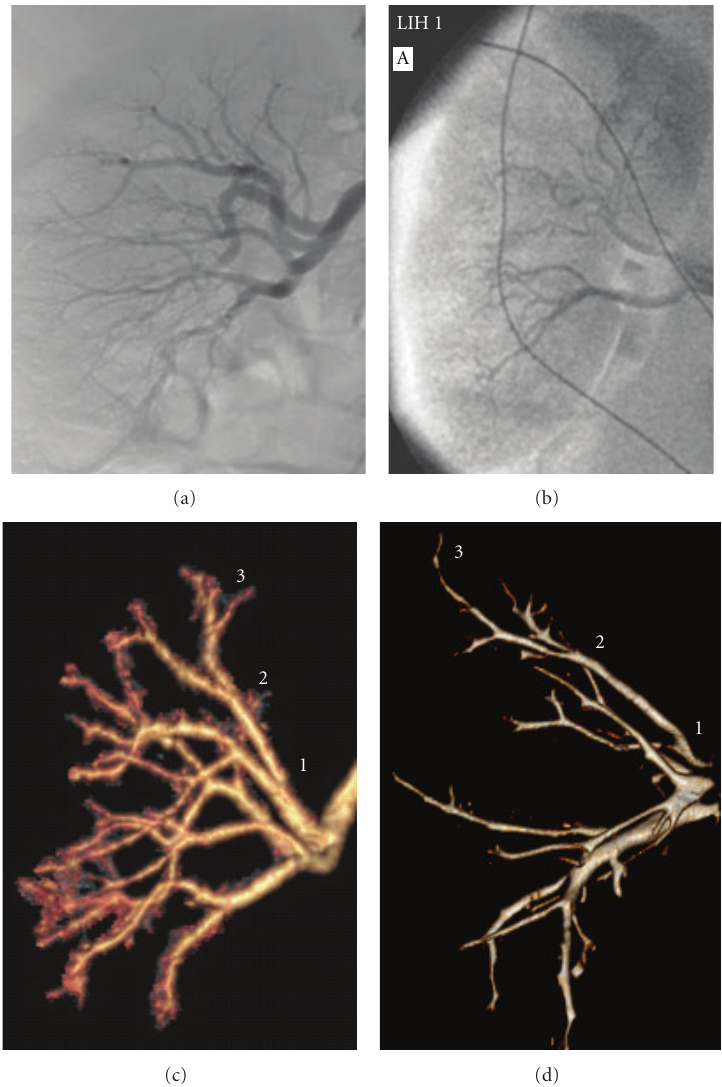
Figure 1: Renal human and pig vasculature. (a, b) are representative angiography pictures, respectively, in human and pig, (c, d) are representative pictures of kidney vasculature obtained with CTscan, respectively, in human and pig. (1) segmental arteries aera ; (2) interlobar arteries aera; (3) arcuate arteries aera